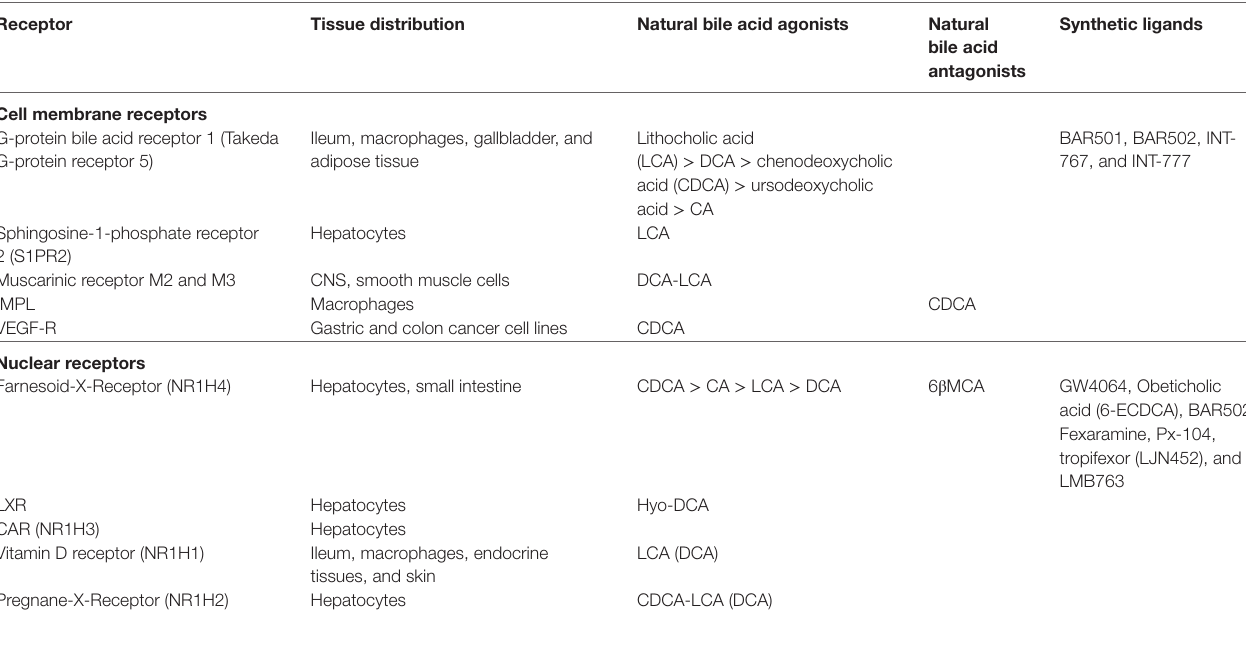
TABLe 1 | Bile acid-activated receptors and natural and synthetic ligands.